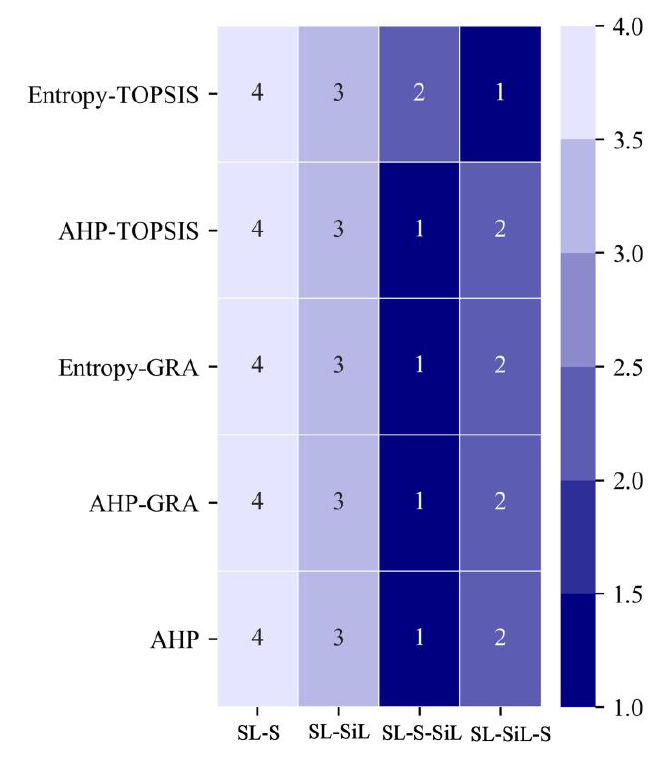
Figure 13. The ranking of soil profiles based on five MCDA methods. GRA, Grey relation analysis.